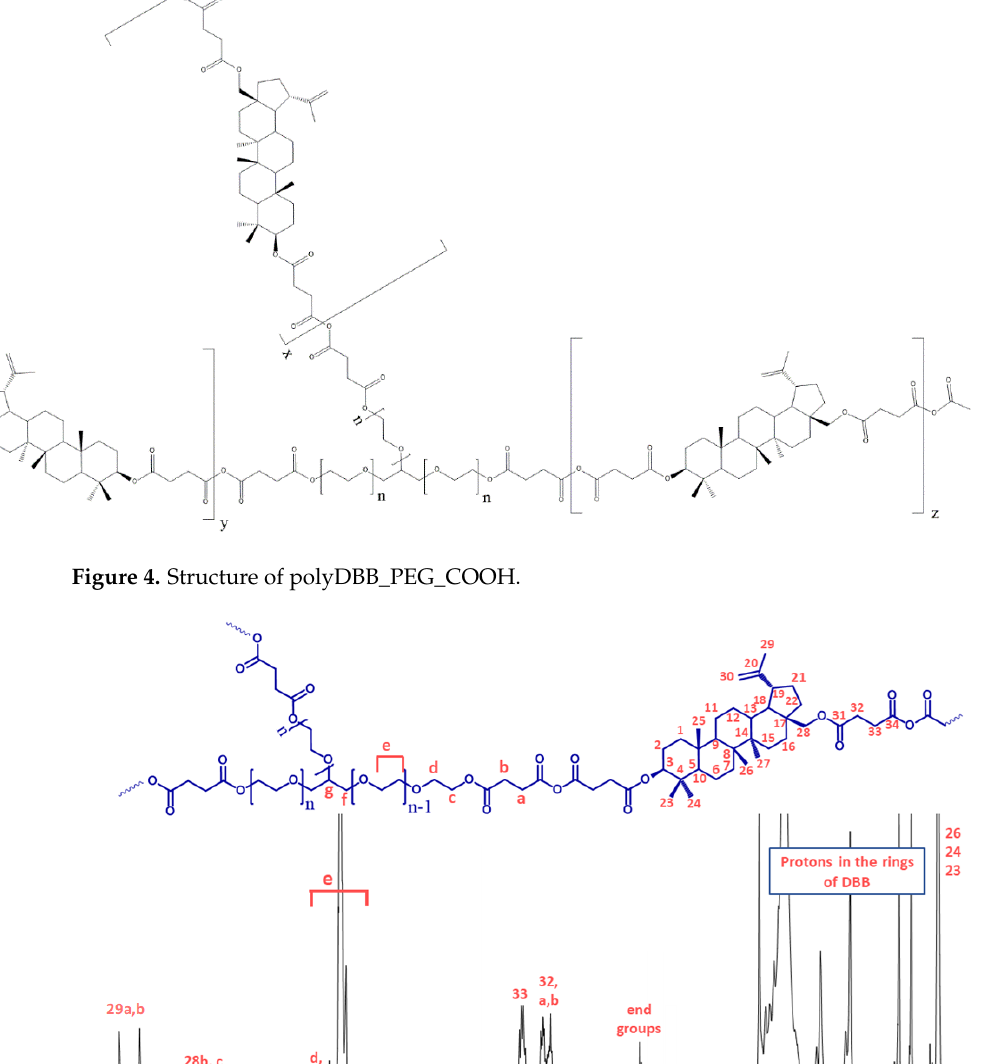
Figure 5. 1 H NMR spectrum of polyanhydrides based on betulin disuccinate and PEG(COOH) 3 .